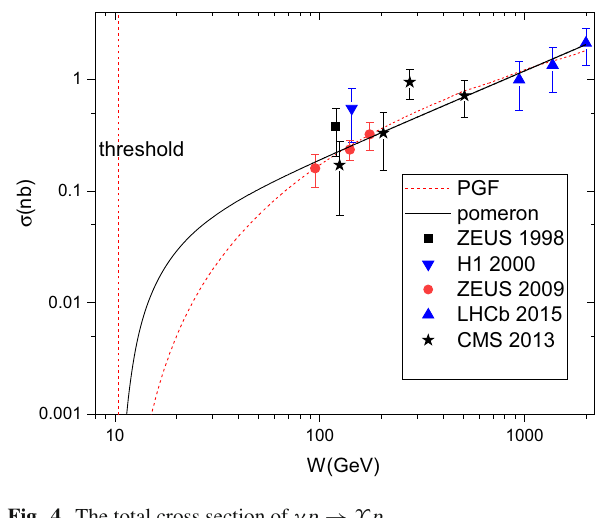
Fig. 4 The total cross section of γ p → Υ